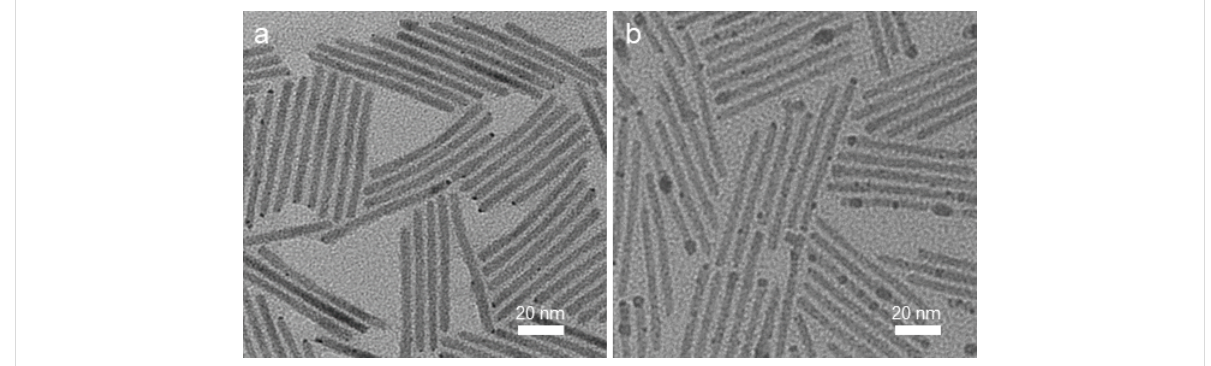
Figure 3: TEM images of metal-decorated CdSe@CdS nanorods prepared using [bmim][Tf 2 N] and metal precursor. a) Au-decorated nanorods ob- tained from AuCl 3 . b) Ag-decorated nanorods obtained from AgNO 3